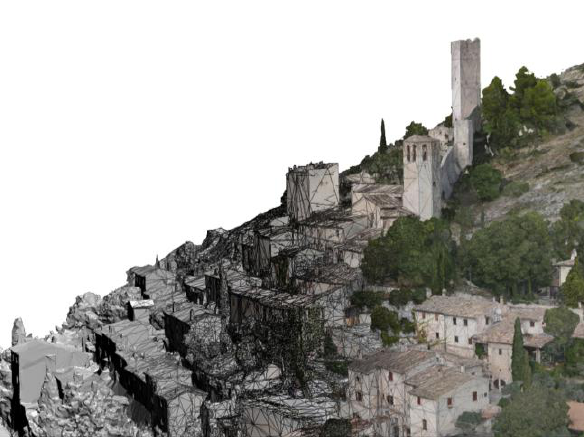
Figure 1. Virtual model of Lizori hamlet